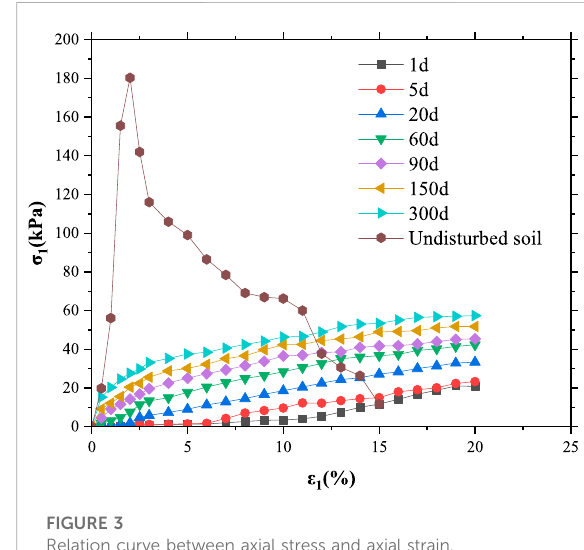
FIGURE 3 Relation curve between axial stress and axial